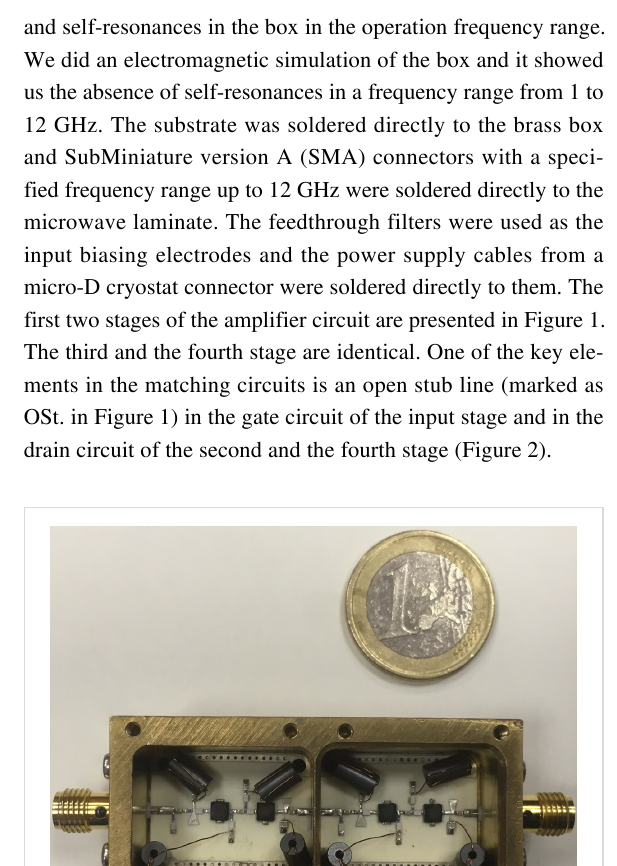
and self-resonances in the box in the operation frequency